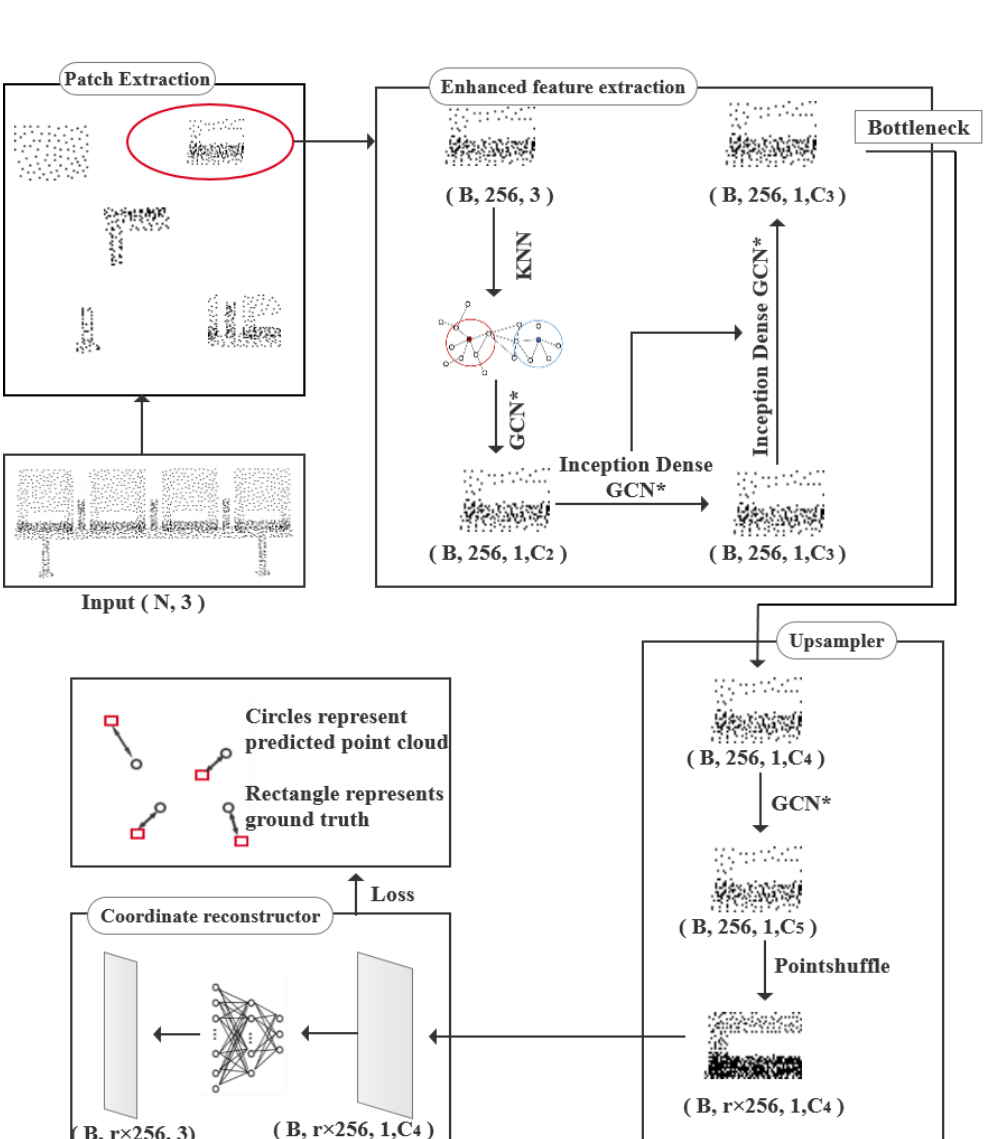
Figure 9. PU-WGCN architecture. PU-WGCN consists of four parts: patch extraction, enhanced feature extraction, upsampler, and coordinate reconstructor. In the enhanced feature extraction module, we construct the local neighborhood graph using KNN. The red circle and blue circle in the figure indicate the point cloud graphs constructed under different local neighborhoods,